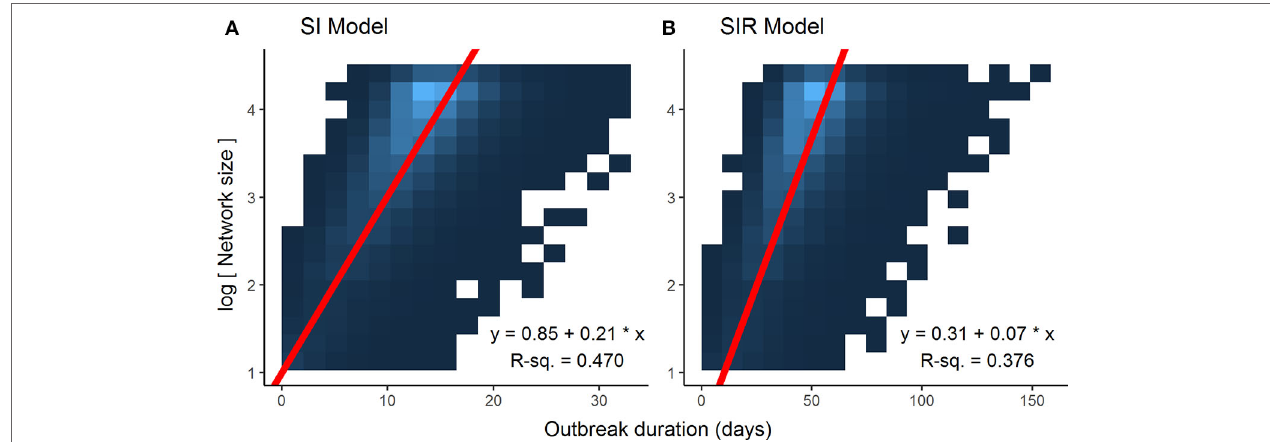
FIGURe 3 | Associations between log-transformed network size and outbreak duration for different disease models. Data points for each graph, limited to networks of 80 nodes or less ( n = 78,000), were too dense to make scatterplot representations intelligible, thus heatmaps were used to illustrate the results, with lighter colors of blue representing a higher density of data points. Log-transforming network size makes for a linear relationship, and reduced major axis model 2 regression lines, represented in red, account best for the joint variation in the x and y axes. (A) Susceptible-infected (SI) model. (B) Susceptible-infected-recovered (SIR)